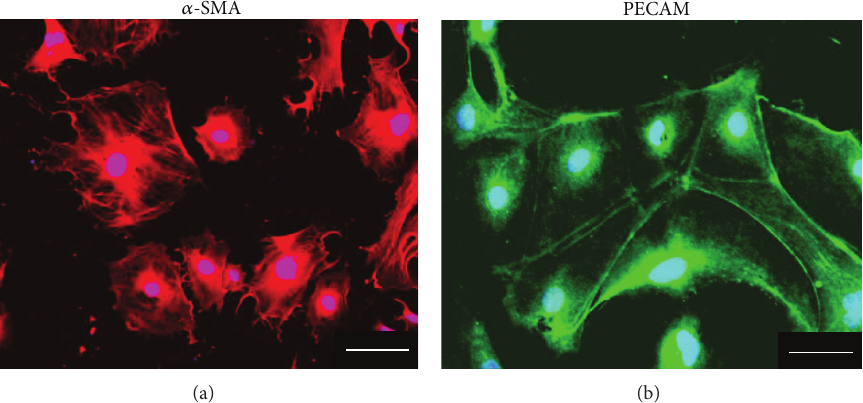
Figure 3: In vitro differentiation potential of angioblast-like cells induced from ES cells (ES-ABs). After a 4-day culture on gelatin, ES-ABs formed many colonies. Immunocytochemistry, a smooth muscle cell marker, 𝛼 -SMA, was detected at some colonies (a), and an endothelial marker, PECAM, was at the other colonies (b). Red: 𝛼 -SMA and green: PECAM. Bar: 100 𝜇